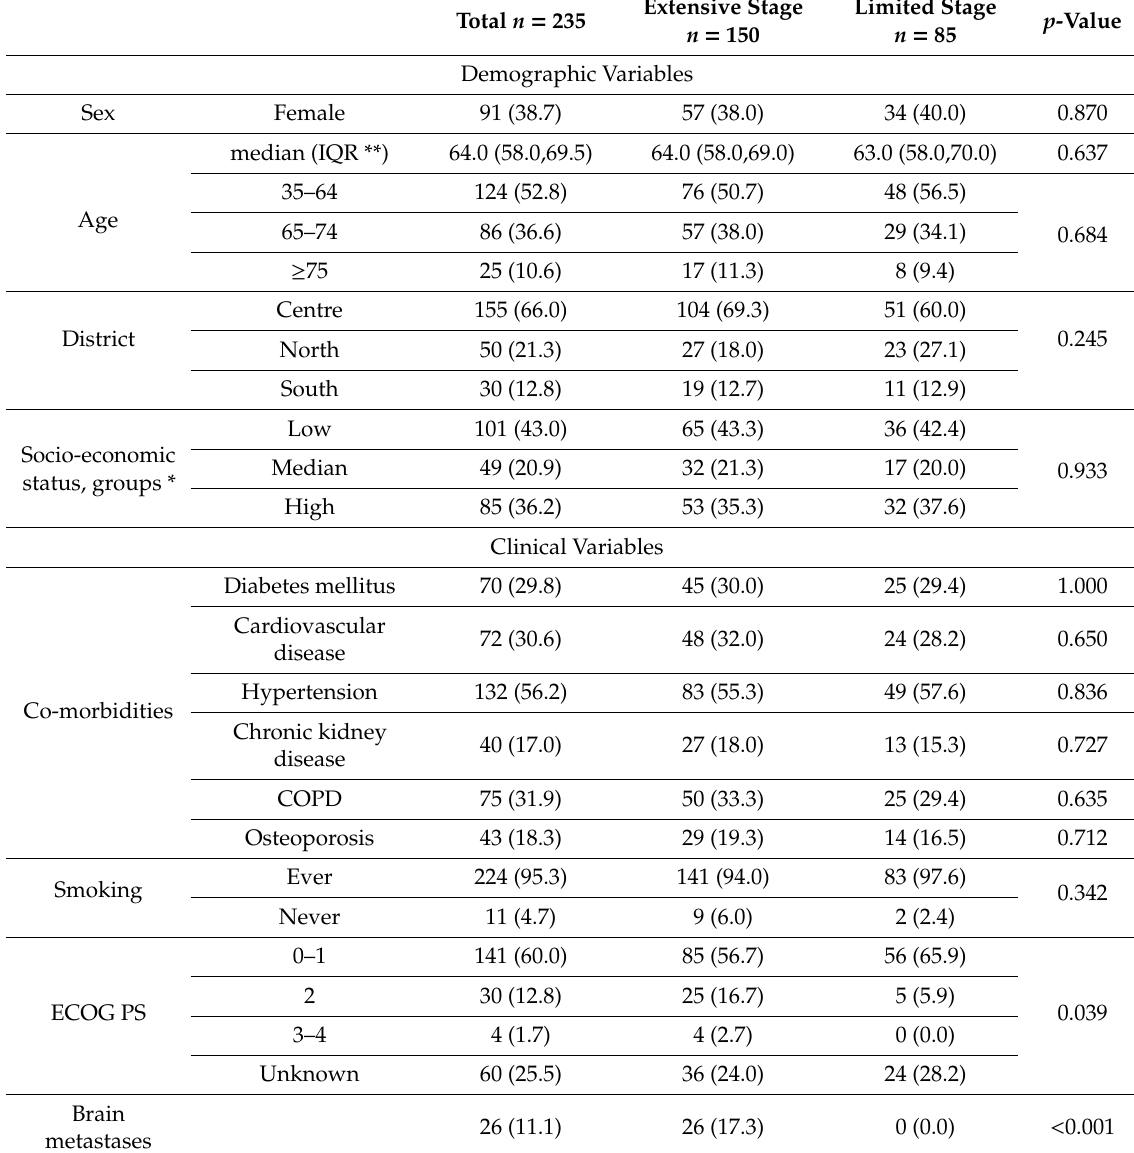
Table 1. Demographic and clinical characteristics of small cell lung cancer (SCLC) patients at index date (initiation of L1 treatment), n = 235. n(%) unless otherwise